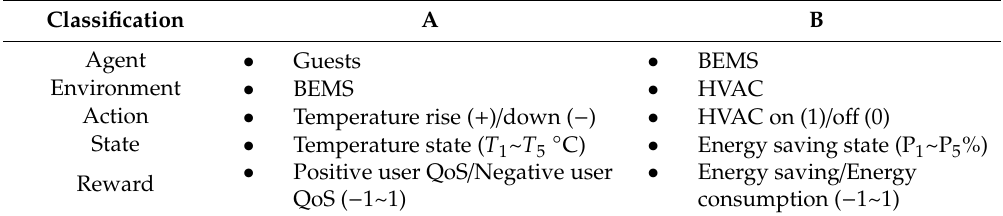
Table 10. The factor of RL-based